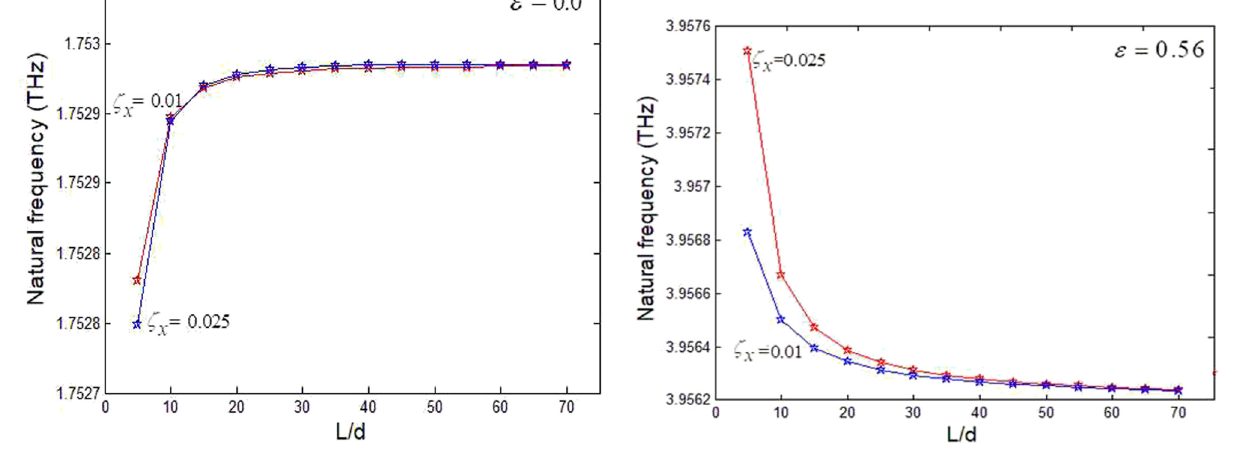
Figure 5: Variations in the natural frequency of uniform single - walled carbon nanotube against aspect ratio ( L / d ) under initial stresses ( ζ = 0.01, 0.025 ) .